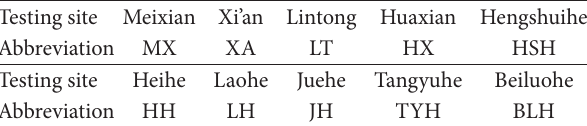
Table 1: Testing sites and the abbreviations in this